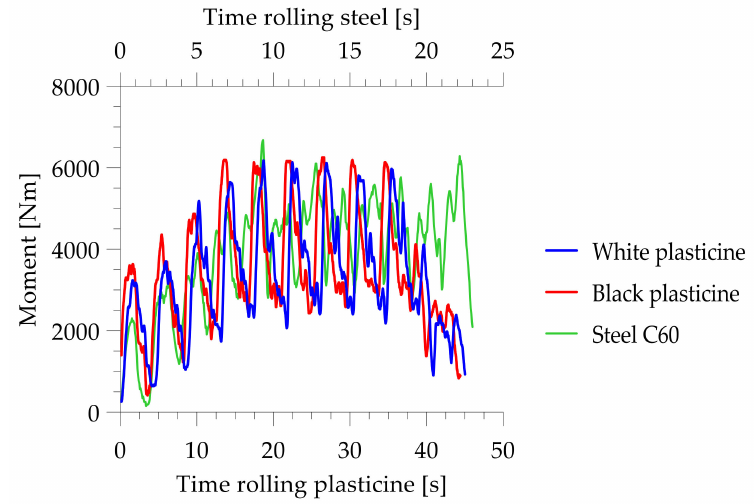
Figure 18. Diagram of torque variation during ball shaping.